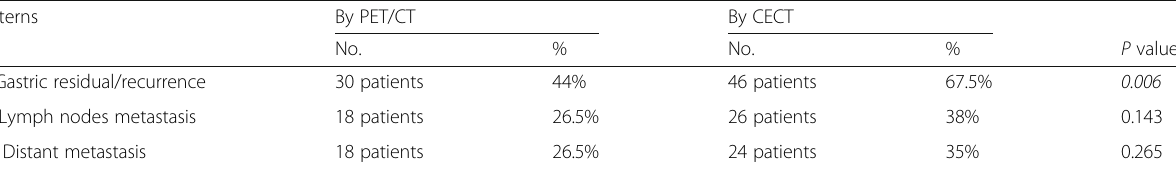
Table 6 Patterns of tumor recurrence/residual, lymph nodes, and distant metastasis in the study by PET/CT in comparison to CECT with their number (No.), percentage (%), and the estimated P value for each pattern by both modalities Patterns By PET/CT By CECT No. % No. % P value